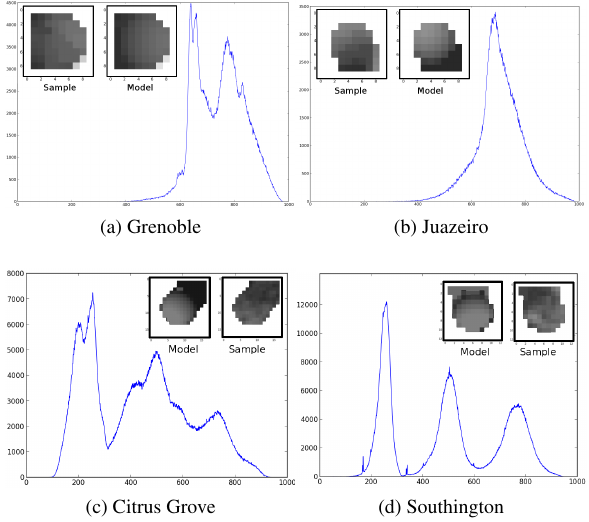
Figure 4: Similarity value histograms for the four test images. The grey tone corner images represent the the scale geometrical- optical models and the sample on which it was